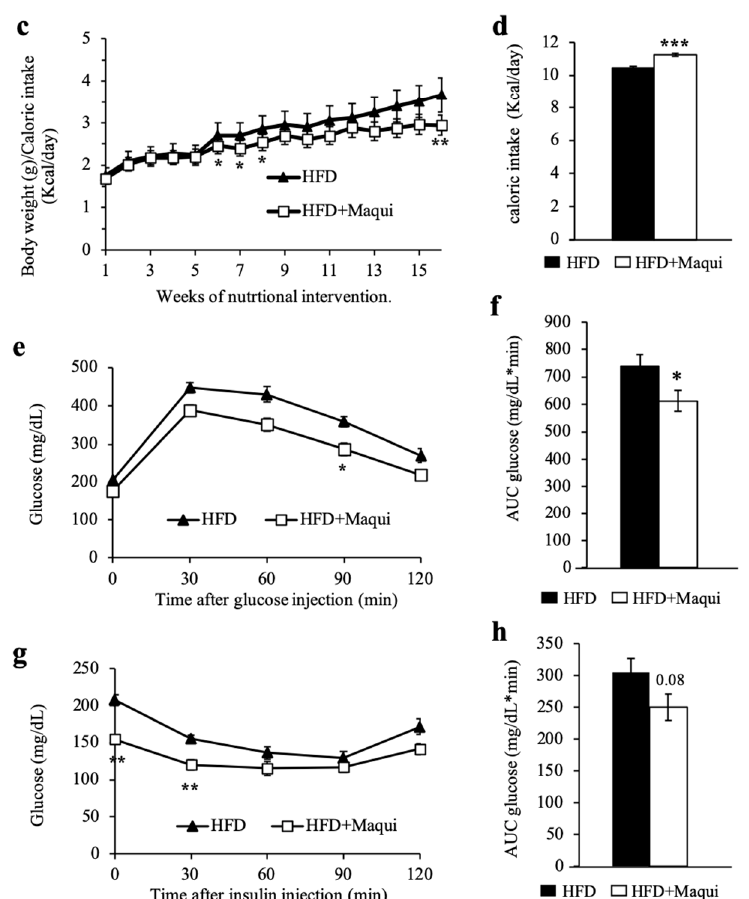
Figure 1. Maqui dietary supplementation reduces HFD-induced body weight gain and improves insulin sensitivity in mice. ( a ) Body weight progression (g) for the 16-week nutritional intervention with maqui. Body weight was recorded twice a week. The graph represents the mean ± SEM of weekly increments in both experimental groups. ( b ) Total body weight increment in grams after 16-week nutritional intervention with maqui. The graph represents the mean ± SEM of the total body weight increment in both experimental groups. ( c ) Body weight (g) related to calorie intake (kcal) per week for the 16-week nutritional intervention with maqui. Calorie intake was calculated based on the energy density of the HFD and the amount of food consumed daily. In HFDM mice, the kcal from maqui were also added. The graph represents the mean ± SEM of the weekly body weight increase related to calorie intake in both experimental groups. ( d ) Calorie intake for both experimental groups during the 16-week nutritional intervention. The graph represents the mean ± SEM. ( e ) GTT curve showing plasma glucose levels after i.p. administration of glucose (1.5 g / kg b.w.) in HFD and HFDM mice after 14 weeks of maqui supplementation. ( f ) AUC of glucose levels in GTT. ( g ) ITT curve showing plasma glucose levels after i.p. administration of insulin (0.5 UI / kg b.w.) in HFD and HFDM mice after 15 weeks of maqui administration. ( h ) AUC of glucose levels in ITT. Data from GTT and ITT are presented as the mean ± SEM. * p < 0.05, ** p < 0.01, *** p < 0.001 versus the HFD